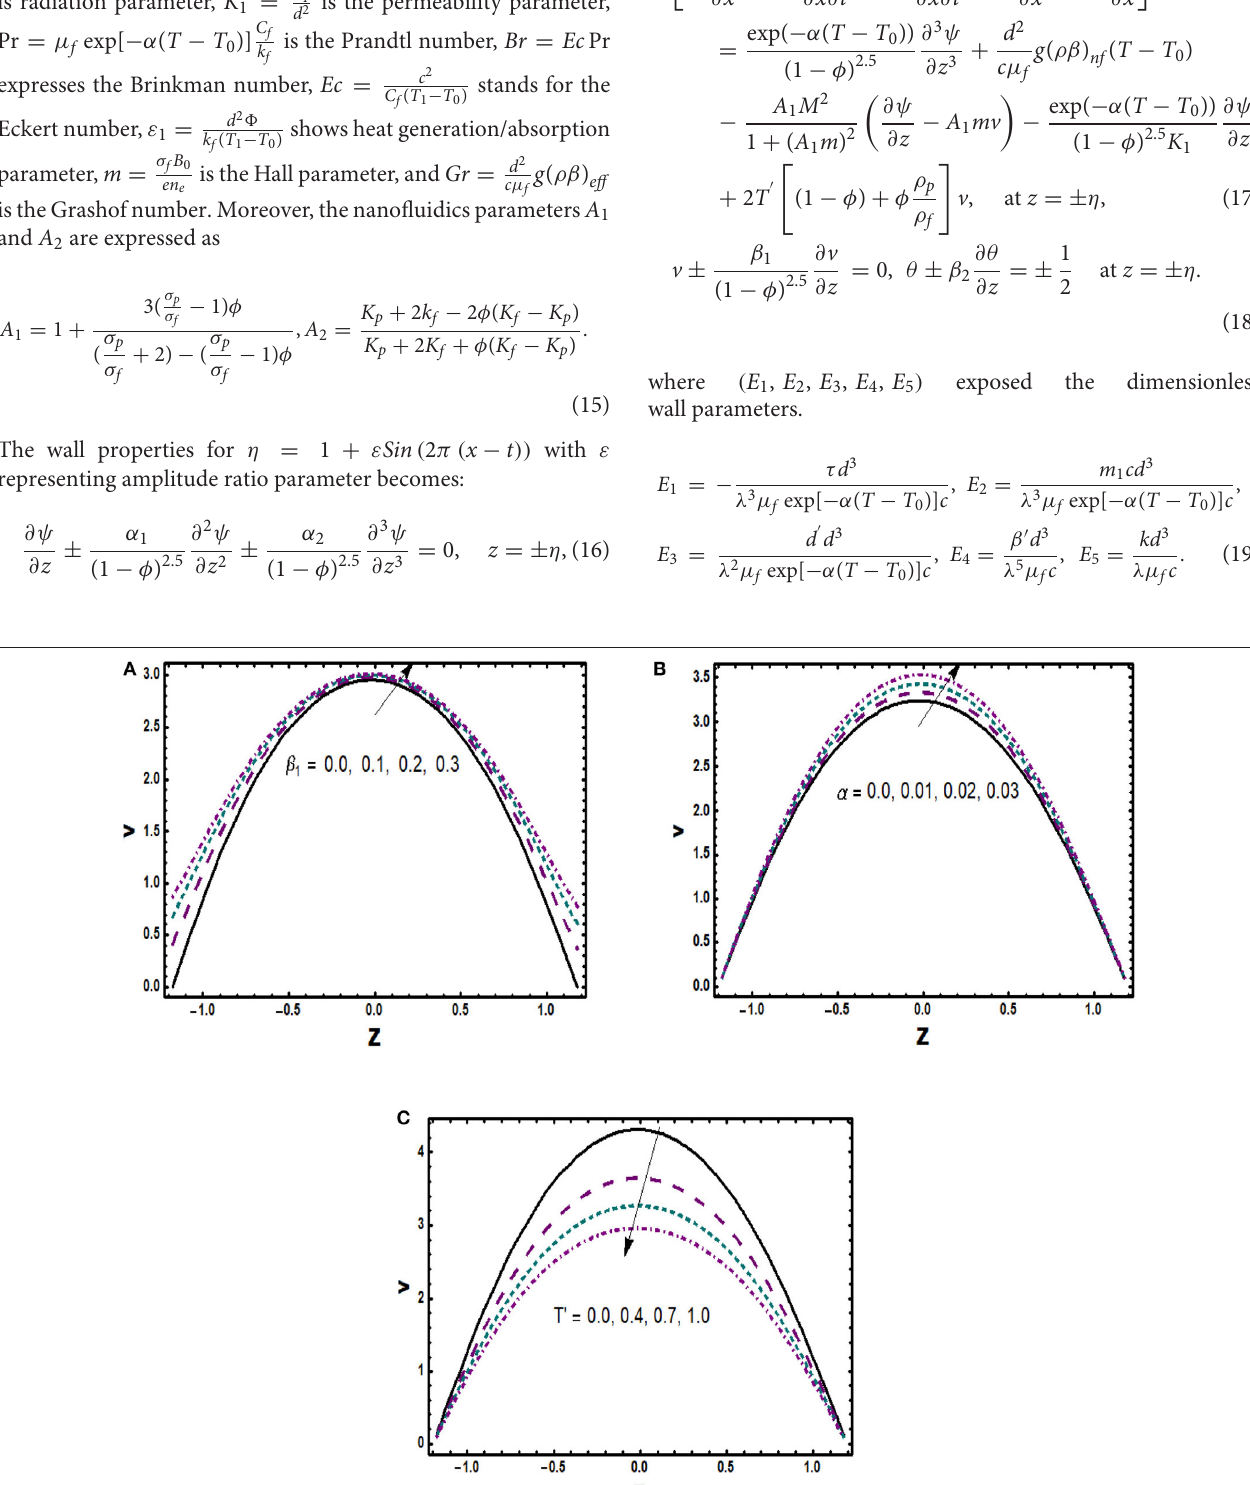
FIGURE 6 | (A–C) Effects of β 1 , α , and T ′ on v(z).